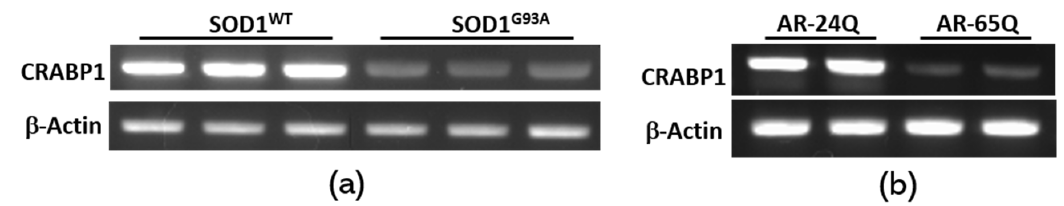
Figure 2. Crabp1 expression in motor neuron disease cell models. ( a ) CRABP1 mRNA levels in SOD1 WT and SOD1 G93A transfected MN1 cells (modeling ALS). ( b ) CRABP1 mRNA levels in AR-24Q and AR-65Q transfected MN1 cells (modeling SBMA). Abbreviations: ALS = amyotrophic lateral sclerosis, SBMA = spinal and bulbar muscular atrophy.